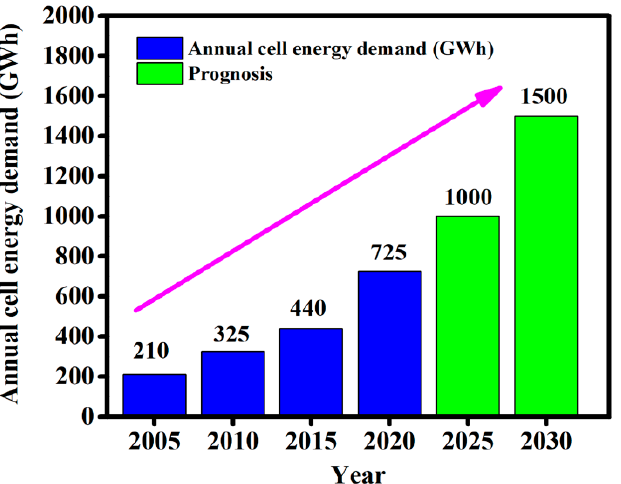
Figure 5. Progress of the rechargeable batteries market as an energy storage system from 2005 to 2030; data recorded from “The Rechargeable Battery Market and Main Trends 2017–2030 (Avicenne Energy, 2019)”.